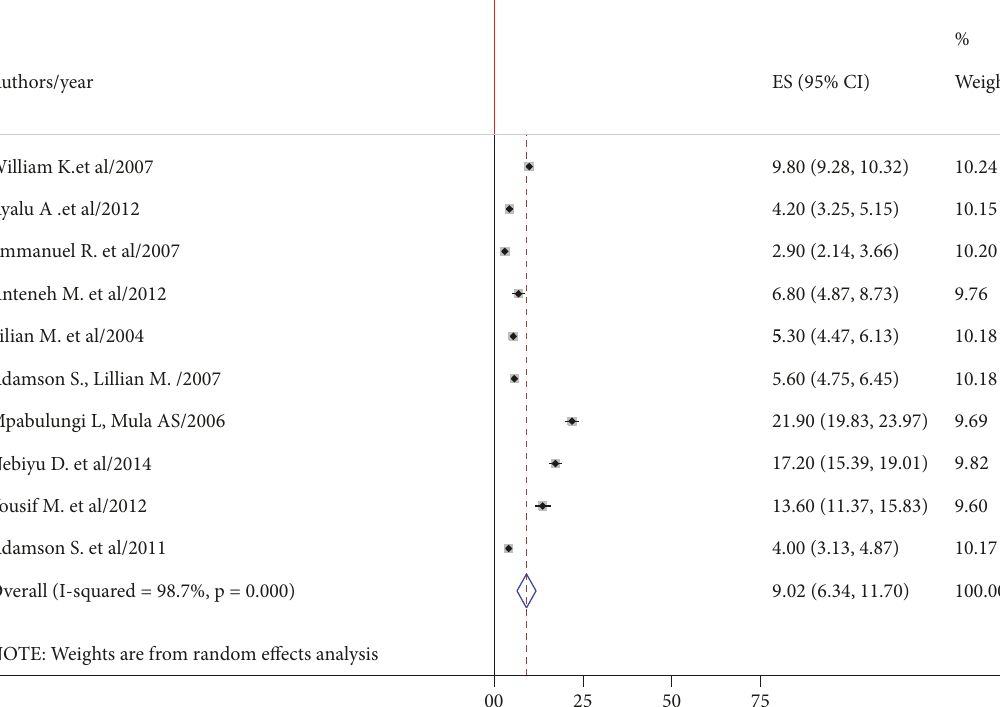
Figure 2: Forest plot of the pooled estimates (ES) cigarette smoking among school-going adolescents. The midpoint and the length of each segment indicated prevalence and a 95% CI, whereas the diamond shape showed the combined prevalence of all